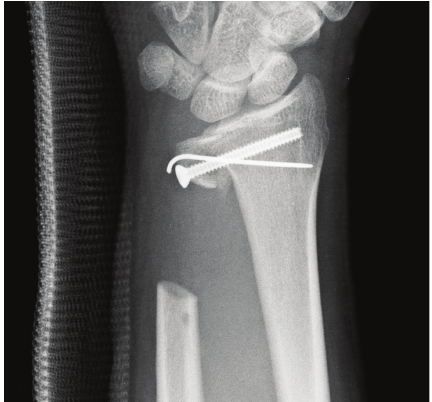
Figure 3: Iliac bone was grafted to the sigmoid notch of the radius. The grafted iliac bone was fixed with a small cortical screw and a 1.5mm diameter Kirschner